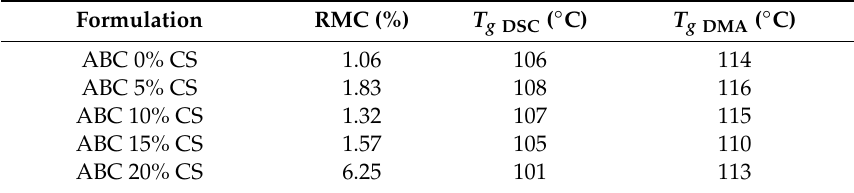
Figure 5. Dynamic mechanical analysis (DMA) of ABCs loaded with CS to 1 Hz of frequency.